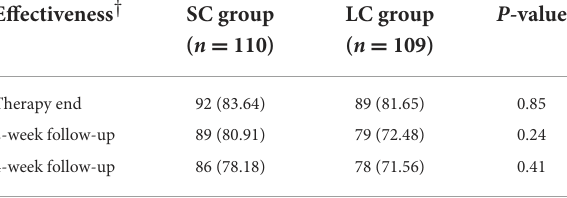
TABLE 3 Effectiveness of dyspeptic symptoms during